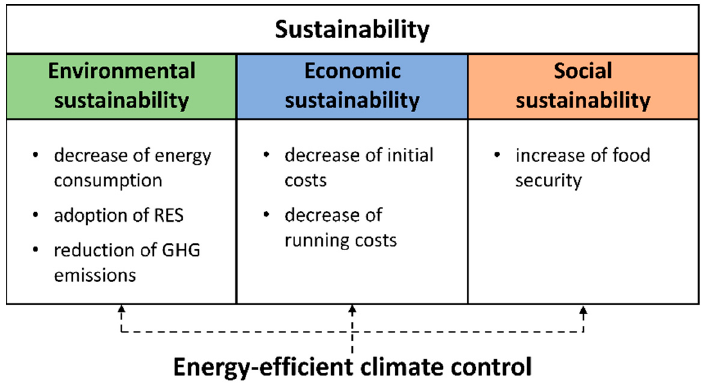
Figure 5. Positive impacts that an energy-efficient climate control of livestock houses could have on the three areas of sustainability, namely, environmental, economic and social sustainability.